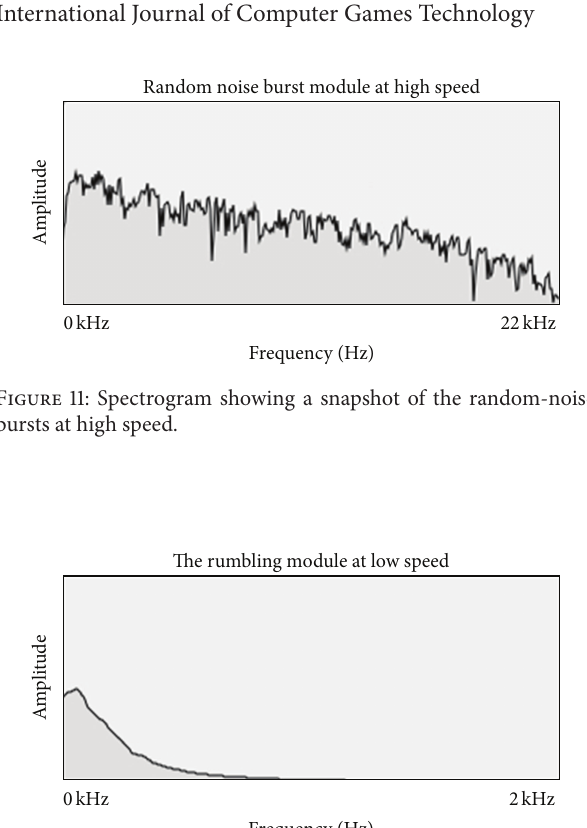
Figure 14: Spectrogram showing a snapshot of the wind module at low